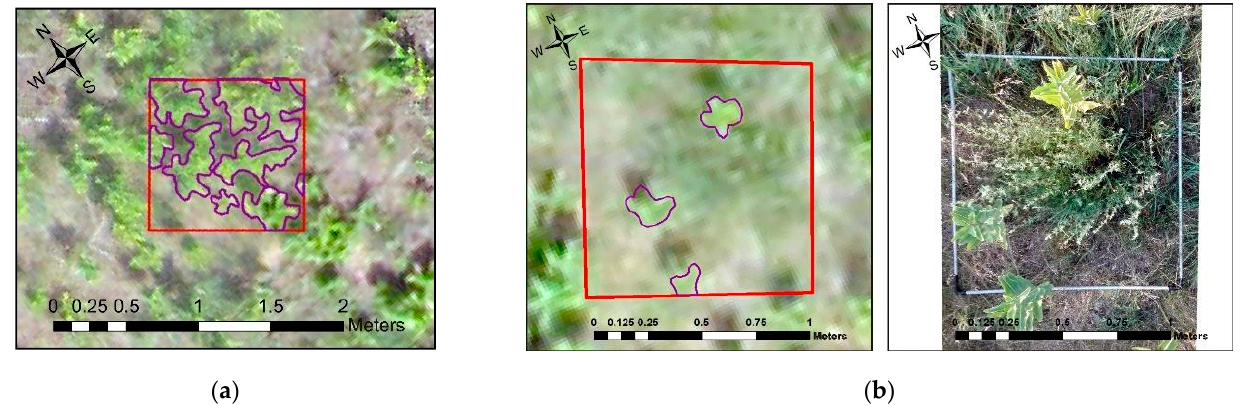
Figure 4. Pictures of common milkweed specimens delineated within the designated quadrats: ( a ) a quadrate in which individual specimens can be clearly delineated in the mosaic photograph; ( b ) it is shown where it can only be delineated by geo-referenced field photography.